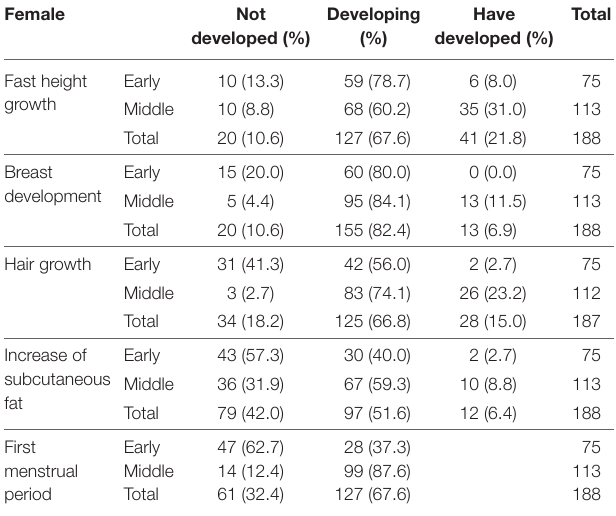
TaBle 4 | The state of development of adolescent physical development in females for each